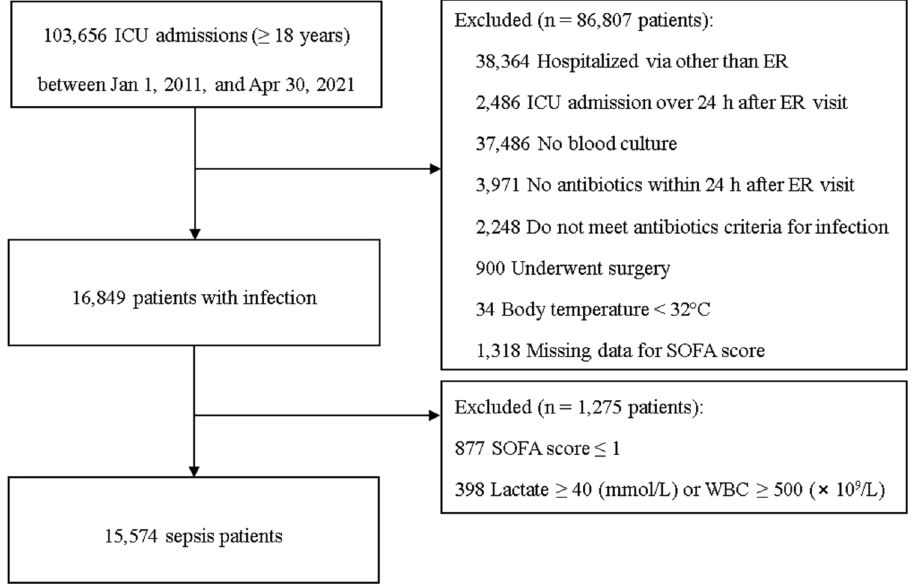
Figure 1. Flow chart of the patients. ICU = intensive care unit; ER = emergency room; SOFA = Sequential Organ Failure assessment; and WBC = white blood